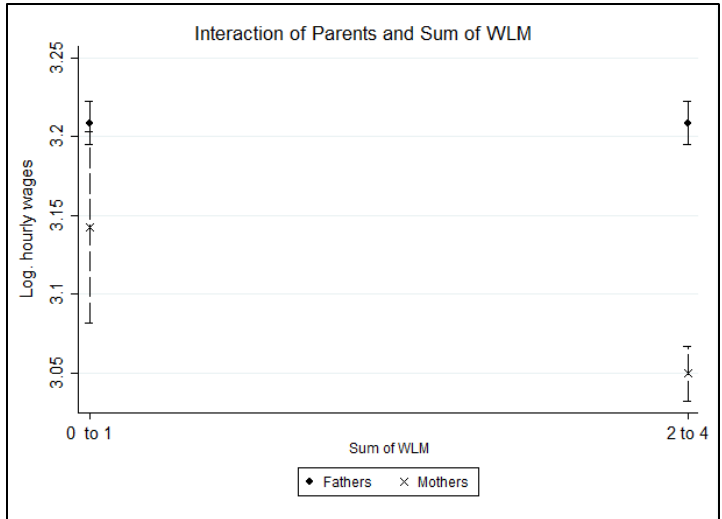
Figure 1. Log. hourly wages of fathers and mothers in association with the amount of WLM (predictive margins of parents with 95% CIs using Stata 14; based on Table